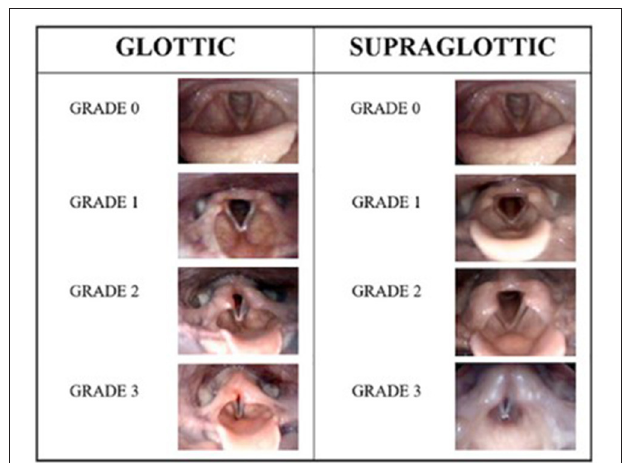
FIGURE 1 | The human grading system according to Maat et al. (24) illustrated by endoscopic photographic images during exercise from the larynx showing the different grades of laryngeal obstruction at the glottic and supraglottic